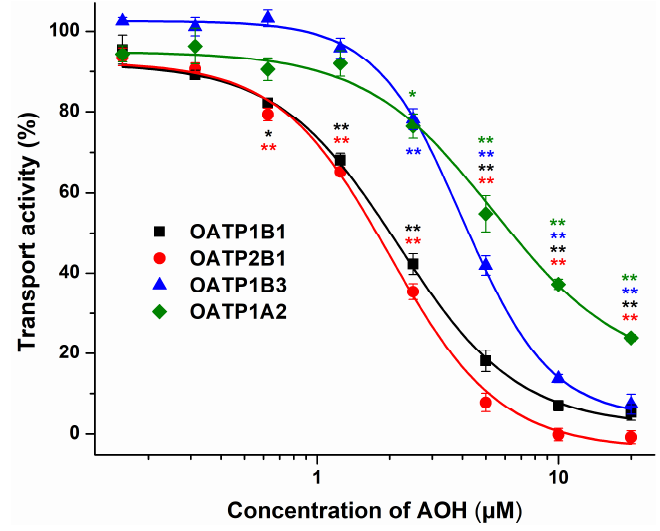
Figure 3. Inhibition of dye uptake in the presence of increasing AOH concentrations (0–20 μM) in A431 cells overexpressing human OATPs (see experimental details in Section 2.5; n = 3; * p < 0.05, ** p < 0.01). ** p < 0.01).